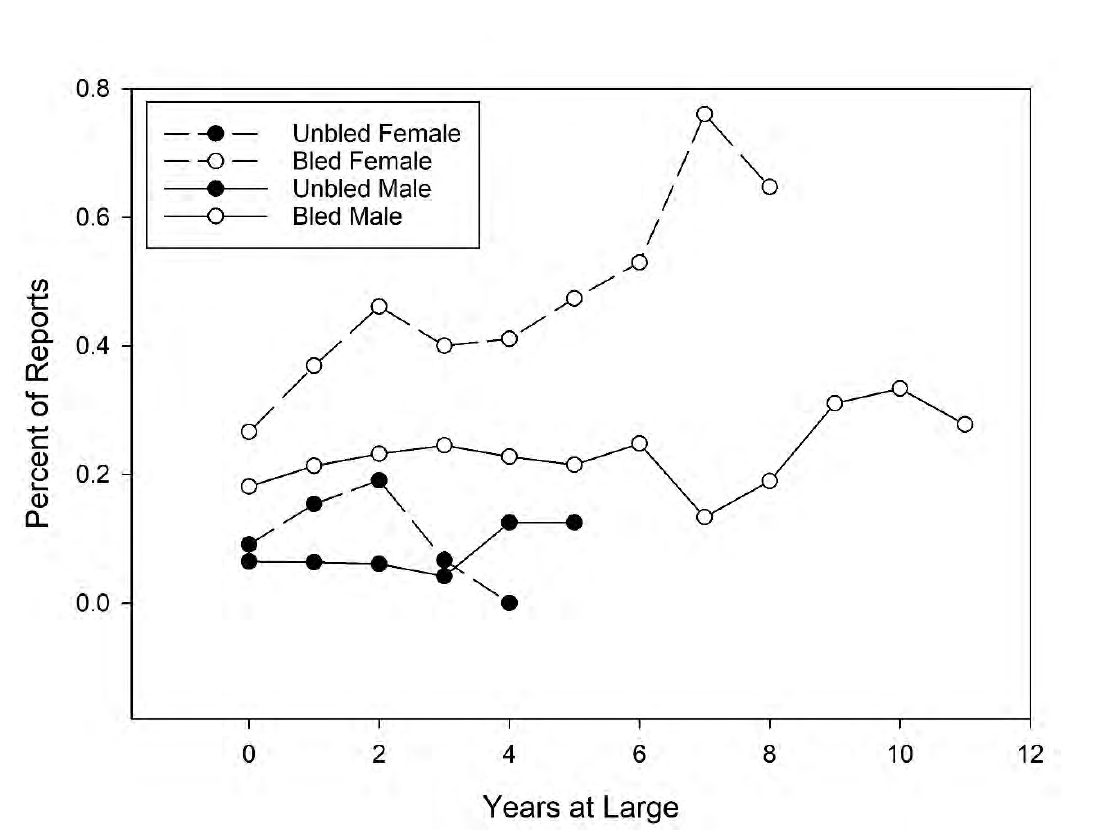
Figure 9. Comparison of bled (open circles) and unbled (filled circles) male (solid line) and female (dashed line) horseshoe crab tags reported as unknown disposition (e.g., tag was found unattached from